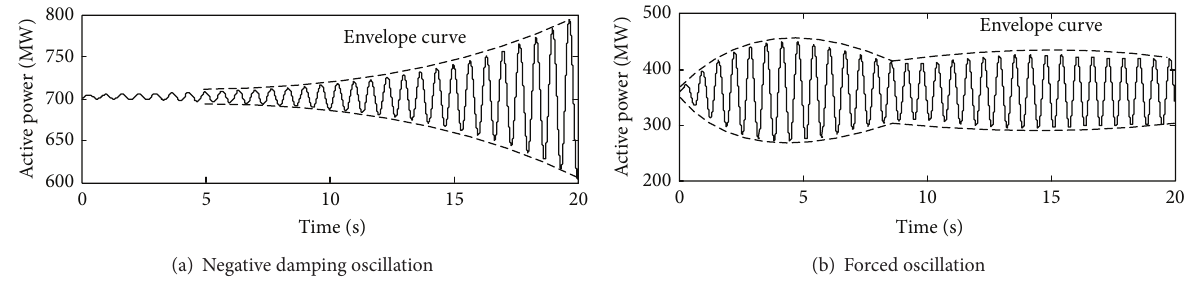
Figure 1: Power oscillation curve of tie line.